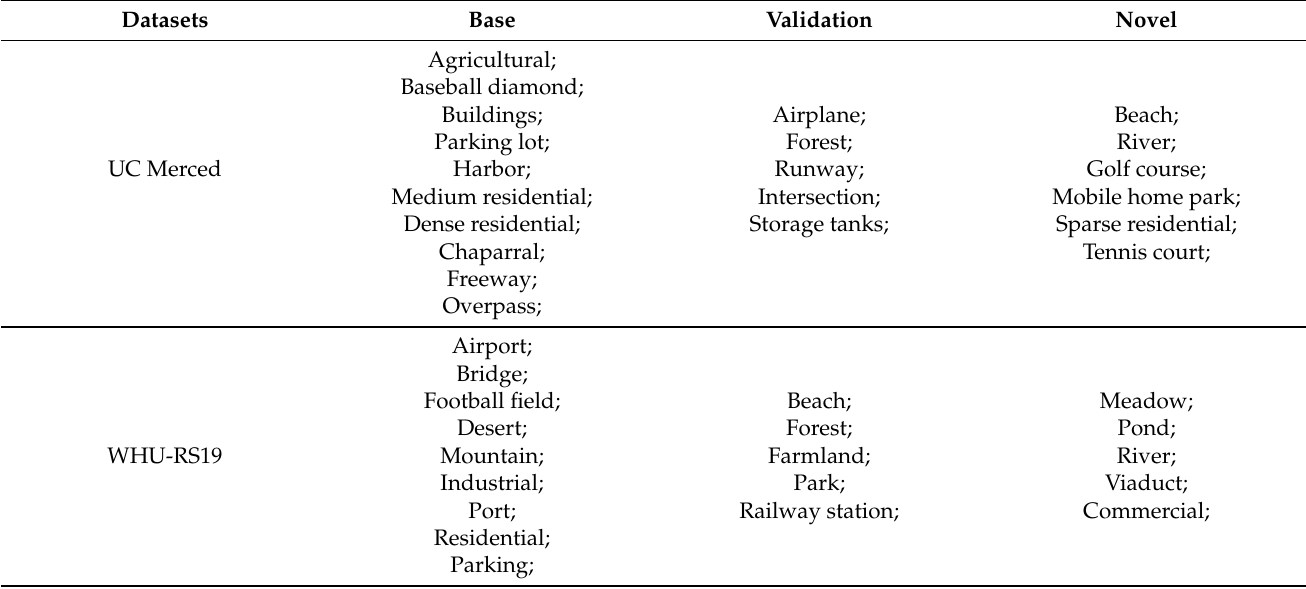
Table 1. The segmentation details of UC Merced dataset, WHU-RS19 dataset, and NWPU- RESISC45